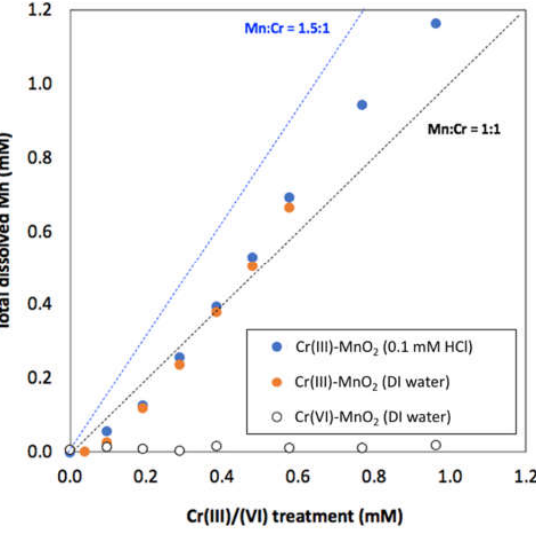
Figure 9. Recovery of dissolved Mn measured as total Mn by MP–AES under the Cr(III) treatment range employed in this study. The dashed lines represent the 1:1 and 1.5:1 Mn:Cr (mol:mol) rela- tionship.